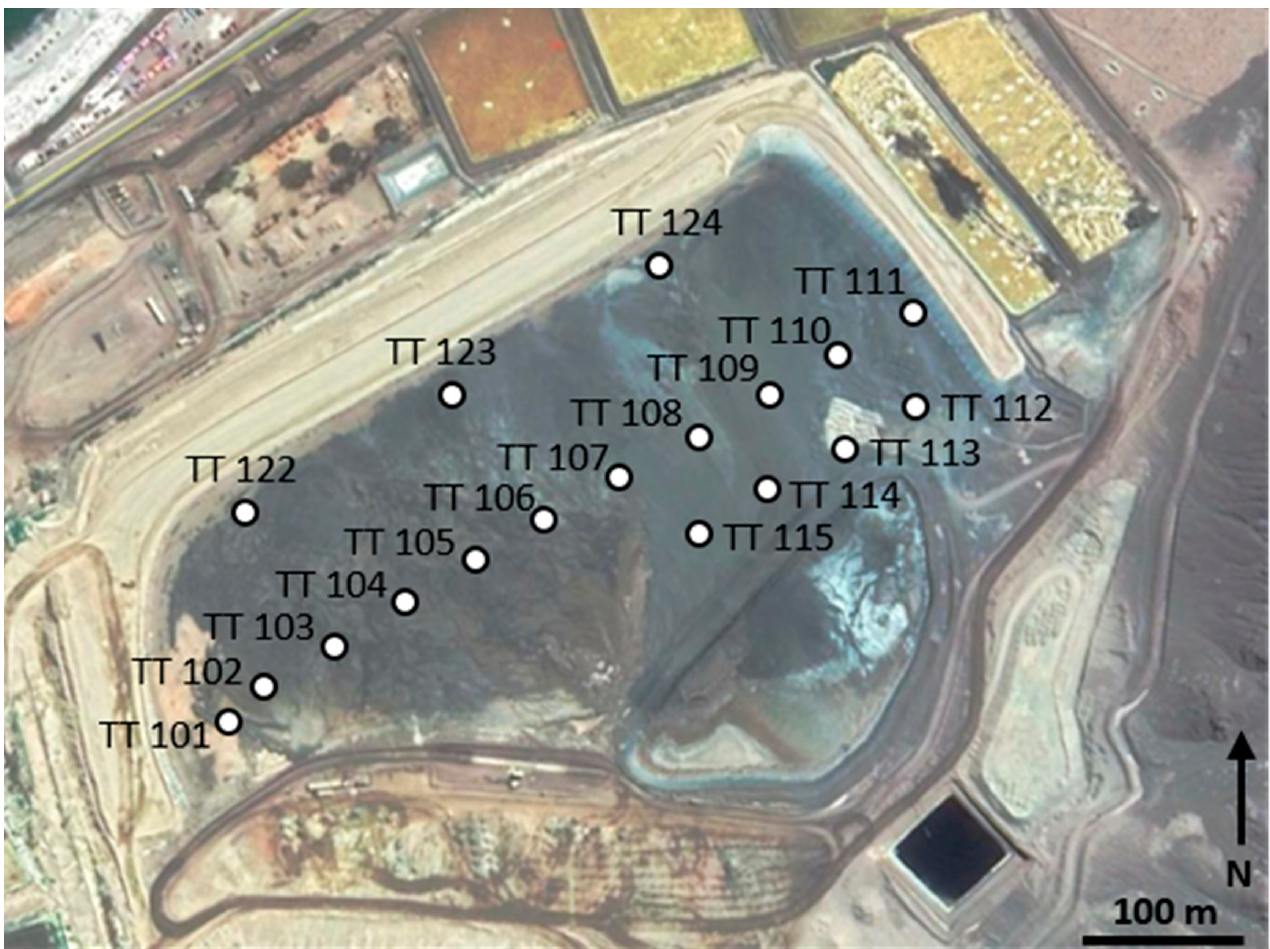
Figure 1. TSF near Taltal (Google Earth) with drilling locations. The tailings have their maximum thickness (15 m) in the northern area (TT 122 to TT 124), where samples were taken up to a depth of 11 m and is thinning to the SSW. There are no drilling spots SE and SW of TT 115, as the tailings pond became very shallow (below 4 m).